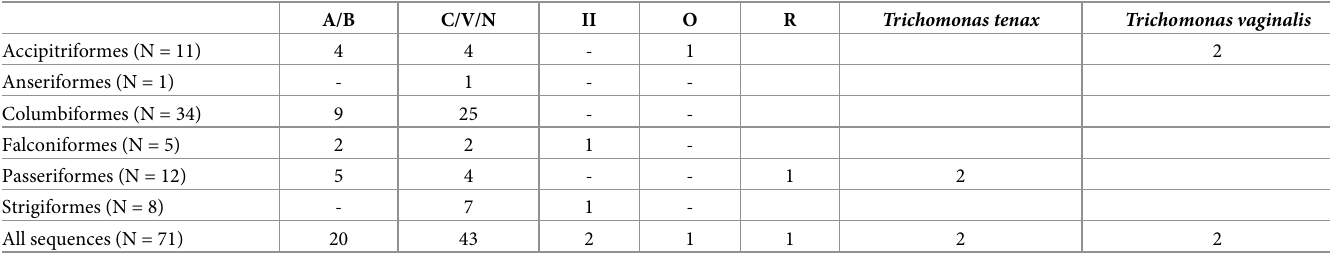
Table 2. Trichomonas species and lineages in bird orders observed in Hesse,